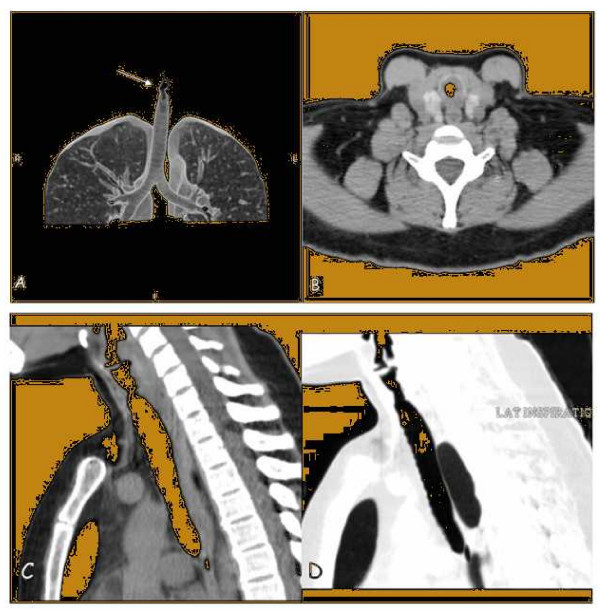
Computed Tomography (CT). (A) CT_ volume rendering technique (VRT): The VRT of the tracheobronchial tree, clearly demonstrates the segment of irregular stenosis of the subglottic trachea (white arrow). (B) CT _axial: CT scan shows marked circumferential narrowing of the subglottic part of the trachea. No calcification can be seen. (C and D) CT_sag_multi planar reconstruction (MPR): On (C) end-expiration and (D) end-inspiration sagittal MPR of CT scan, a dynamic collapse of the trachea can not be documented.